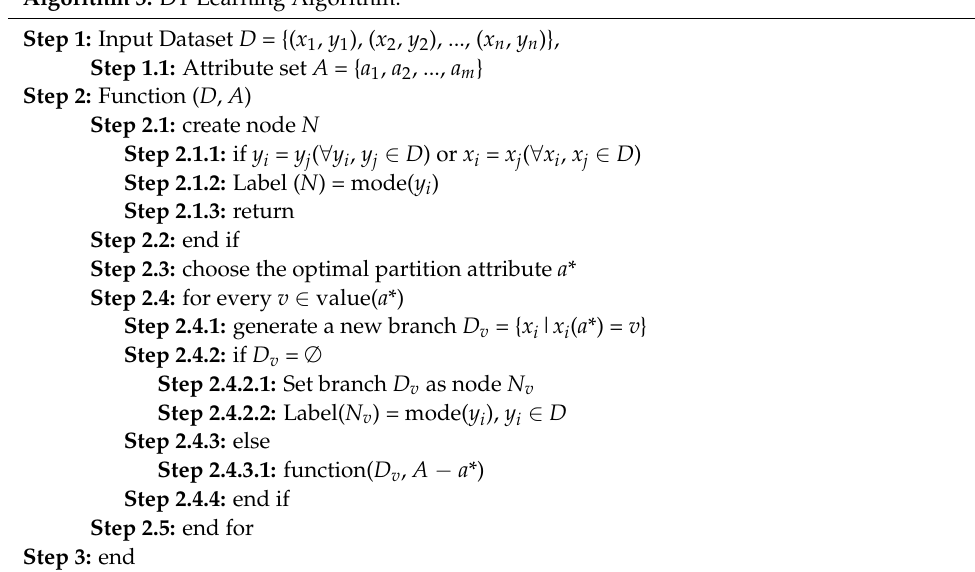
Algorithm 3 defines our general DT model. Algorithm 3: DT Learning